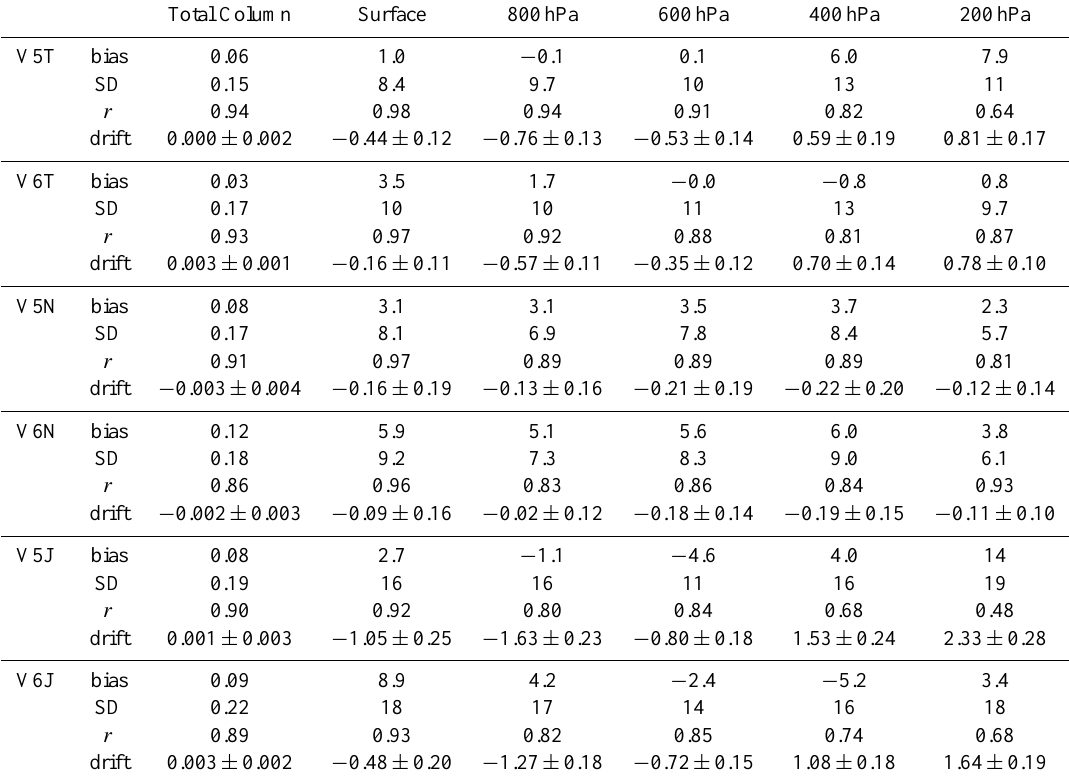
Table 2. Summarized validation results for V5 and V6 TIR-only (V5T and V6T), NIR-only (V5N and V6N), and TIR/NIR (V5J and V6J) products based on in situ data from NOAA validation sites. Bias and standard deviation statistics for the total column are in units of 10 18 molcm − 2 . Bias and standard deviations for retrieval levels are expressed in %. Total column drift is in units of 10 18 molcm − 2 yr − 1 . Drift for the retrieval levels is expressed in %yr − 1